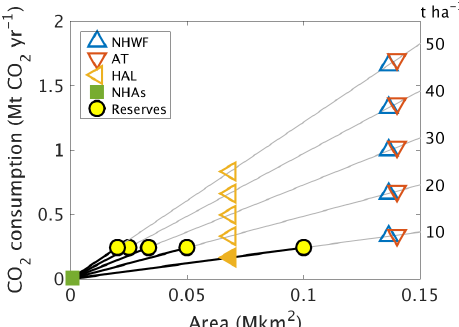
Figure 6. Projected CO 2 consumption following higher-dosage treatments. We considered the possibility of higher-dosage sili- cate treatments on other northeastern United States higher-altitude forests affected by acid rain, such as Acer saccharum forests in New Hampshire (NHAs), the High Allegheny Plateau (HAL) ecore- gion, the Appalachian trail corridor (AT), or northern hardwood forests (NHWFs) dominated by the same tree species as at Hubbard Brook. Because the world’s wollastonite reserves (yellow discs) are insufficient to treat these areas, other calcium-rich silicate min- erals would be required. CO 2 consumption due to higher dosage (tha − 1 ) is estimated as (mean observed CO 2 , Ca between 2004 and 2012) × area × dosage / 3.44tha − 1